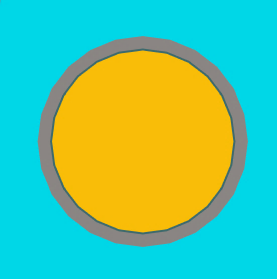
Figure 5. Single Fuel Pin Cell with 3.64 wt.% UO 2 as Modeled by MPACT. There are nine different fuel assemblies: A0, B0, B1, B2, B3, C0, C1, C2, and C3. These use different configurations of 1.71 wt.% UO 2 , 2.64 wt.% UO 2 , 3.14 wt.% UO 2 , 3.64 wt.% UO 2 .